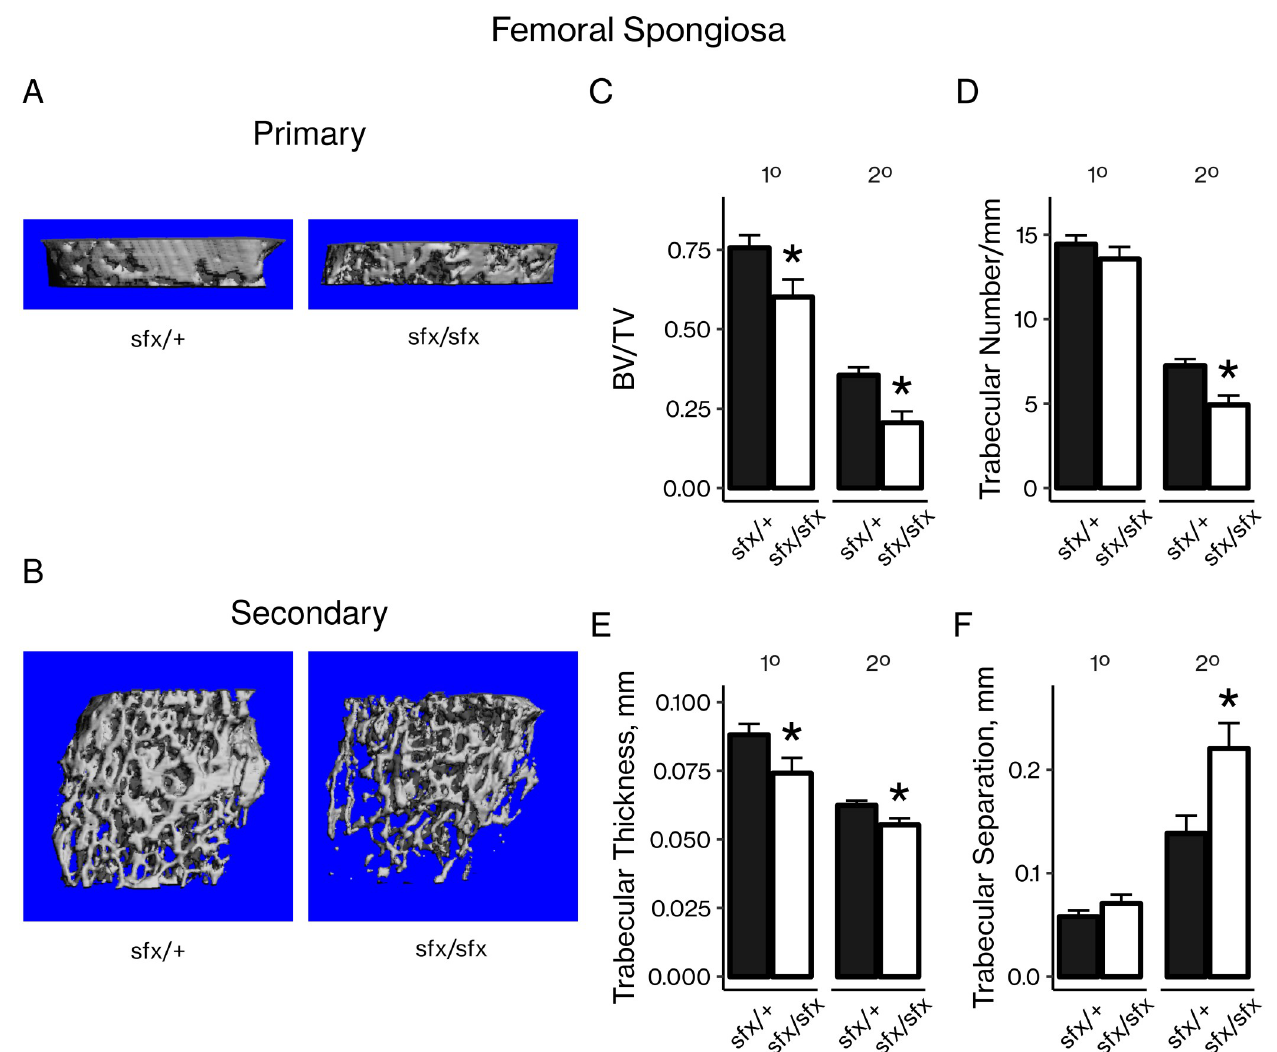
Fig 2. AA-deficient sfx mice had less trabecular bone at the femoral primary and secondary spongiosa. Representative microCT images of (A) primary and (B) secondary spongiosa from control sfx /+ mice and AA-deficient sfx / sfx mice. Scans were quantitated by (C) bone volume adjusted for tissue volume (BV/TV), (D) trabecular number, (E) trabecular thickness, and (F) trabecular separation. Results are presented as mean ± SEM. � P < 0.05 vs. control (Student’s t -test), n = 6 per group.